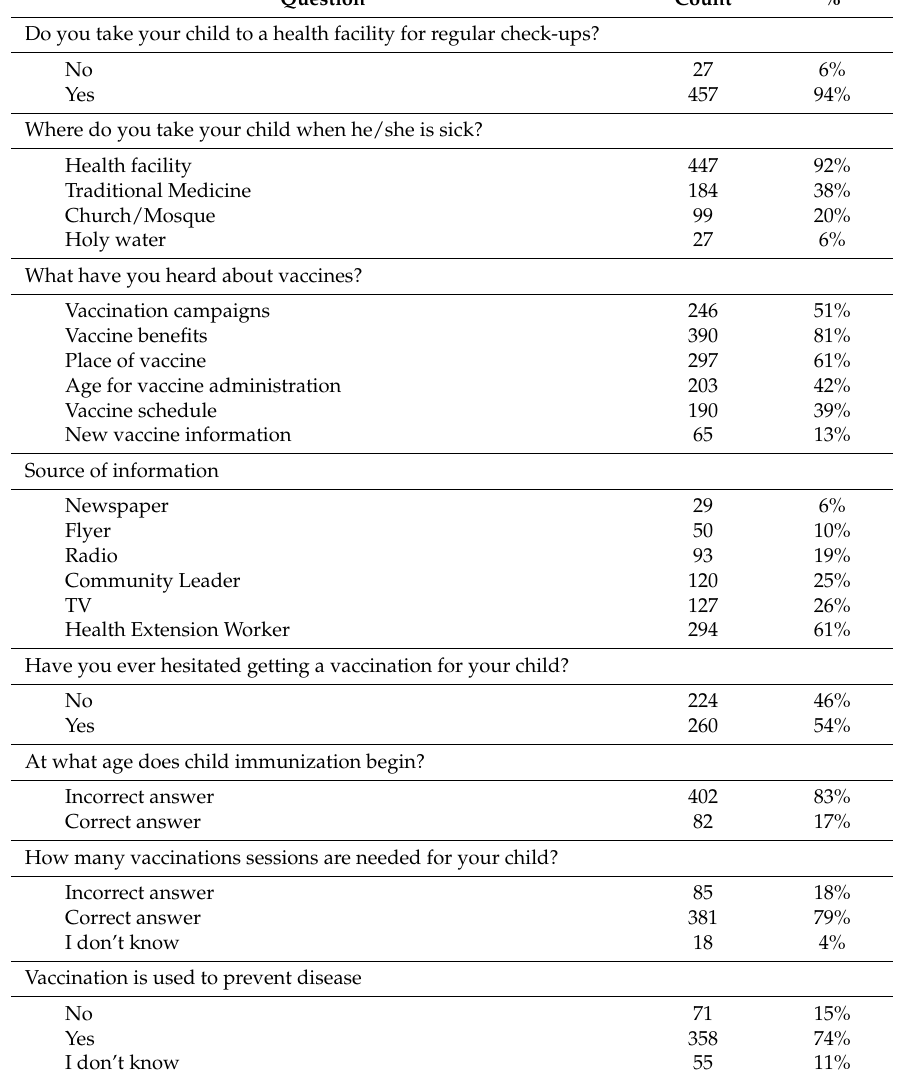
Table 2. Mothers’ awareness of vaccination and health care programs in Worabe, Southern Nations, Nationalities, and Peoples’ Region, Ethiopia,